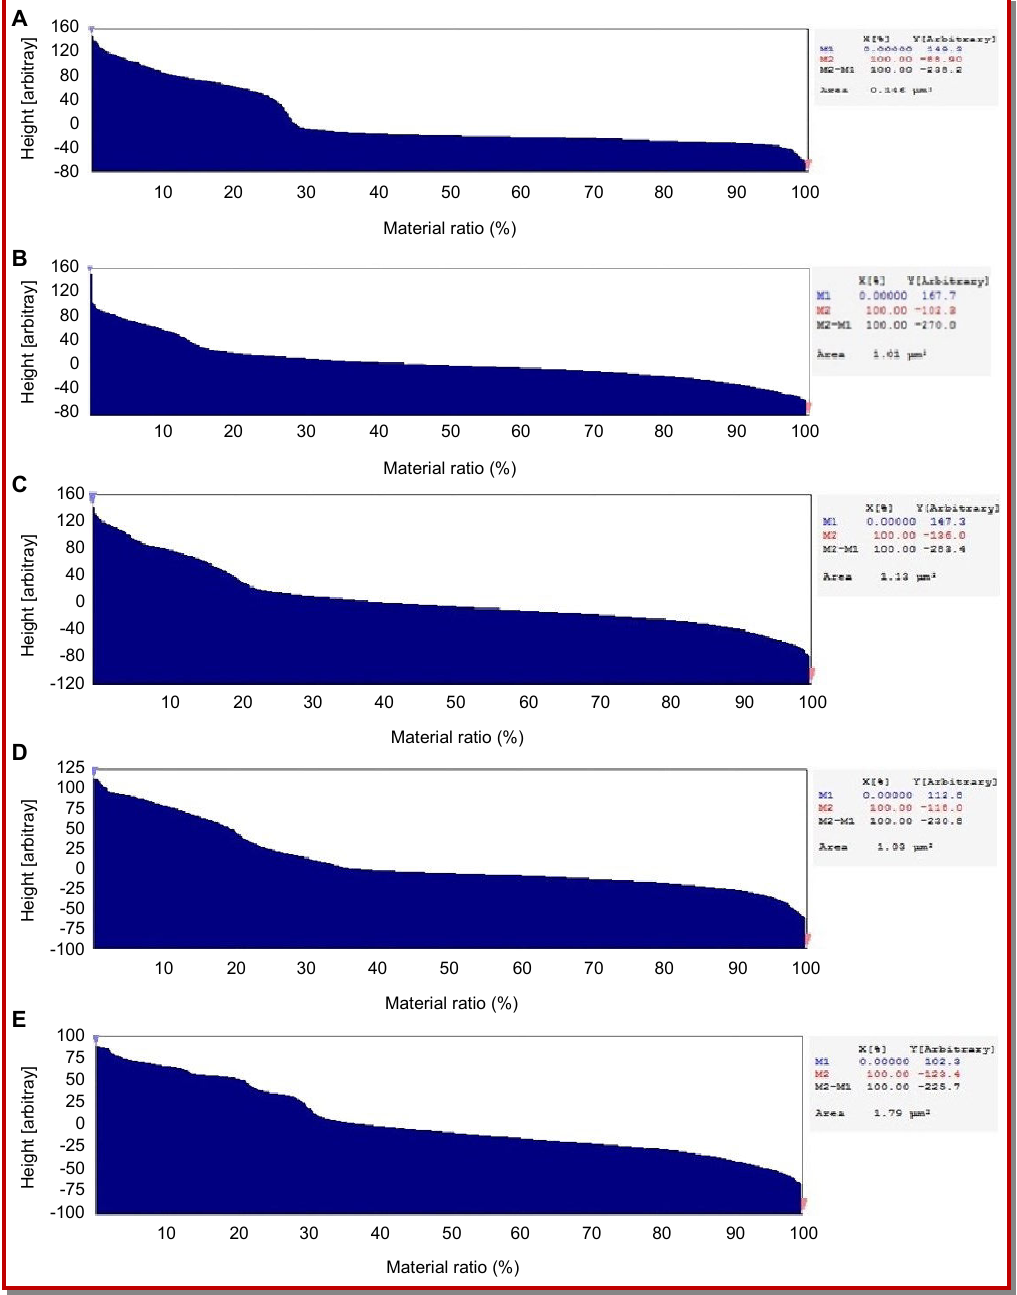
Figure 2: CAM assay Abbott curve of blood vessels, control (A), 20 µL (B), 50 µL(C), 75 µL(D) and 150 µL